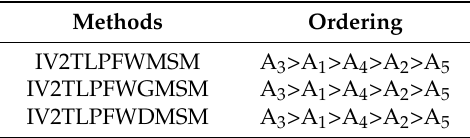
Table 4. Ordering of the green